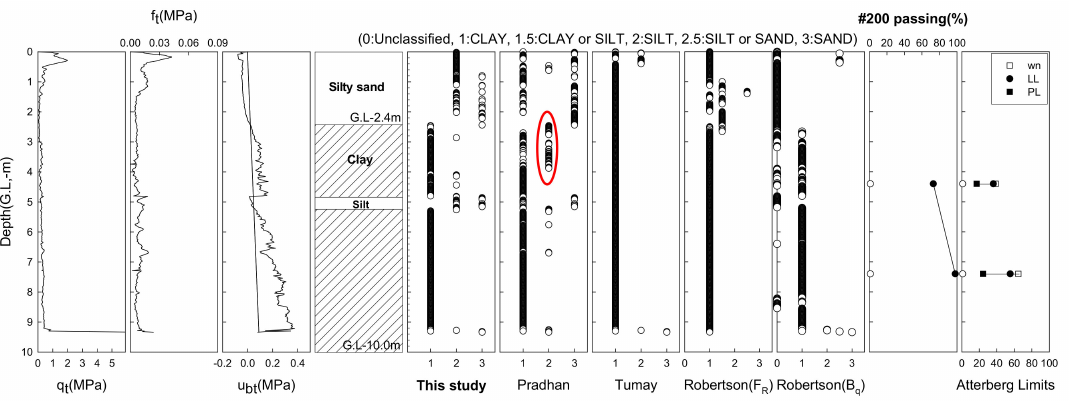
Figure 11. Verification results at Yangsan